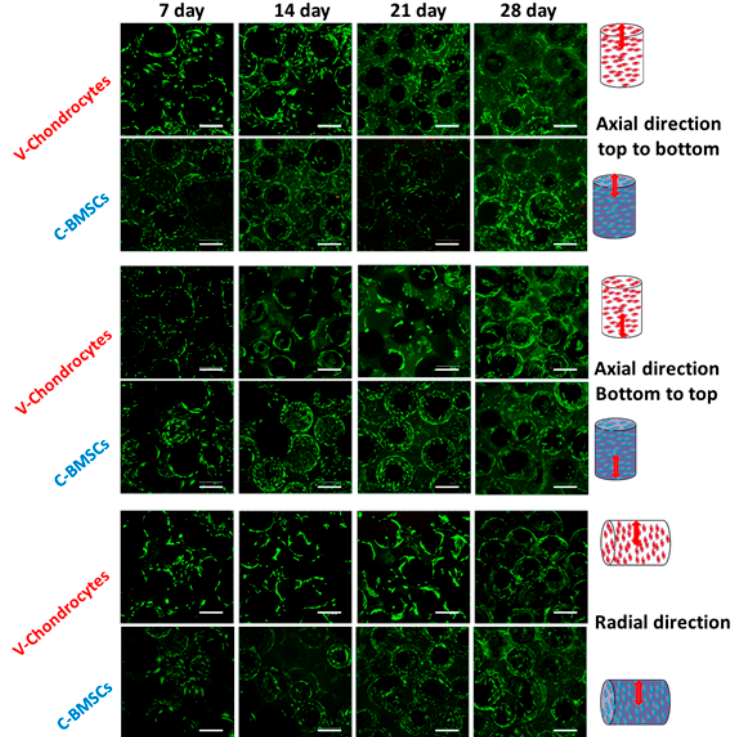
Figure 5. Live/Dead assays of mono-cultured chondrocytes in V scaffolds and BMSCs in C scaffolds. Confocal laser scanning microscope images from axial and radial directions at day 7, 14, 21, and 28 indicate the spread nature and uniform distribution of both cells. Bar = 300 µm.